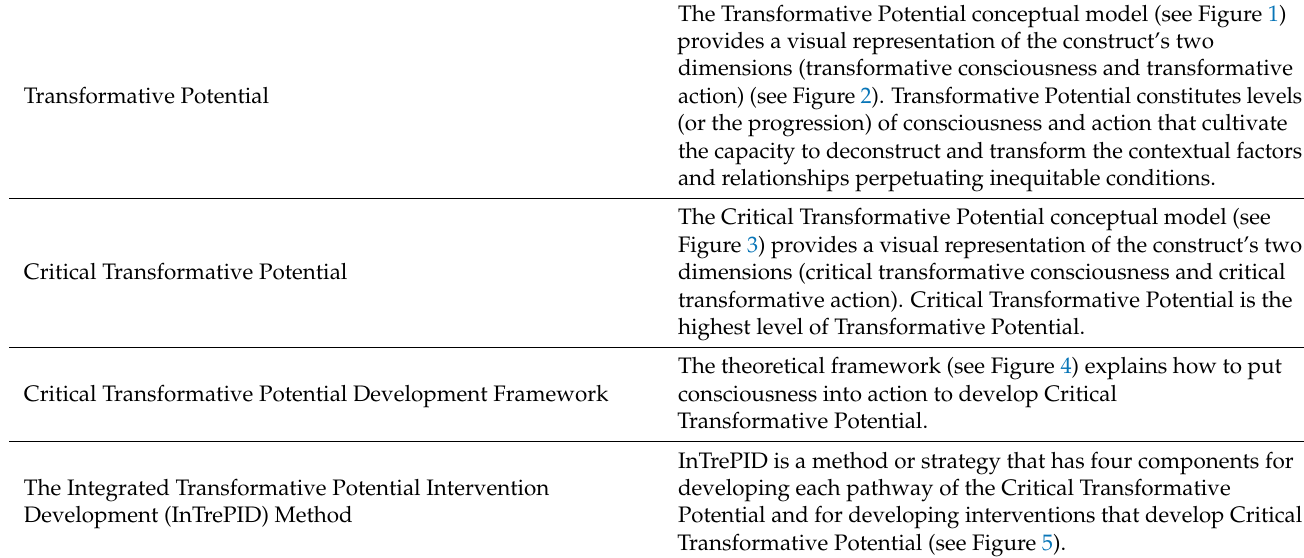
Table 1. From Transformative Potential to the InTrePID